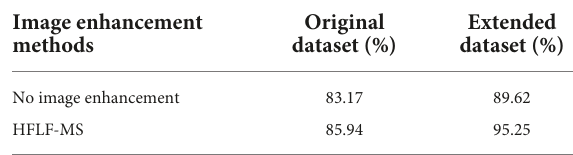
TABLE 7 Classification accuracy of different networks before and after image augmentation and dataset